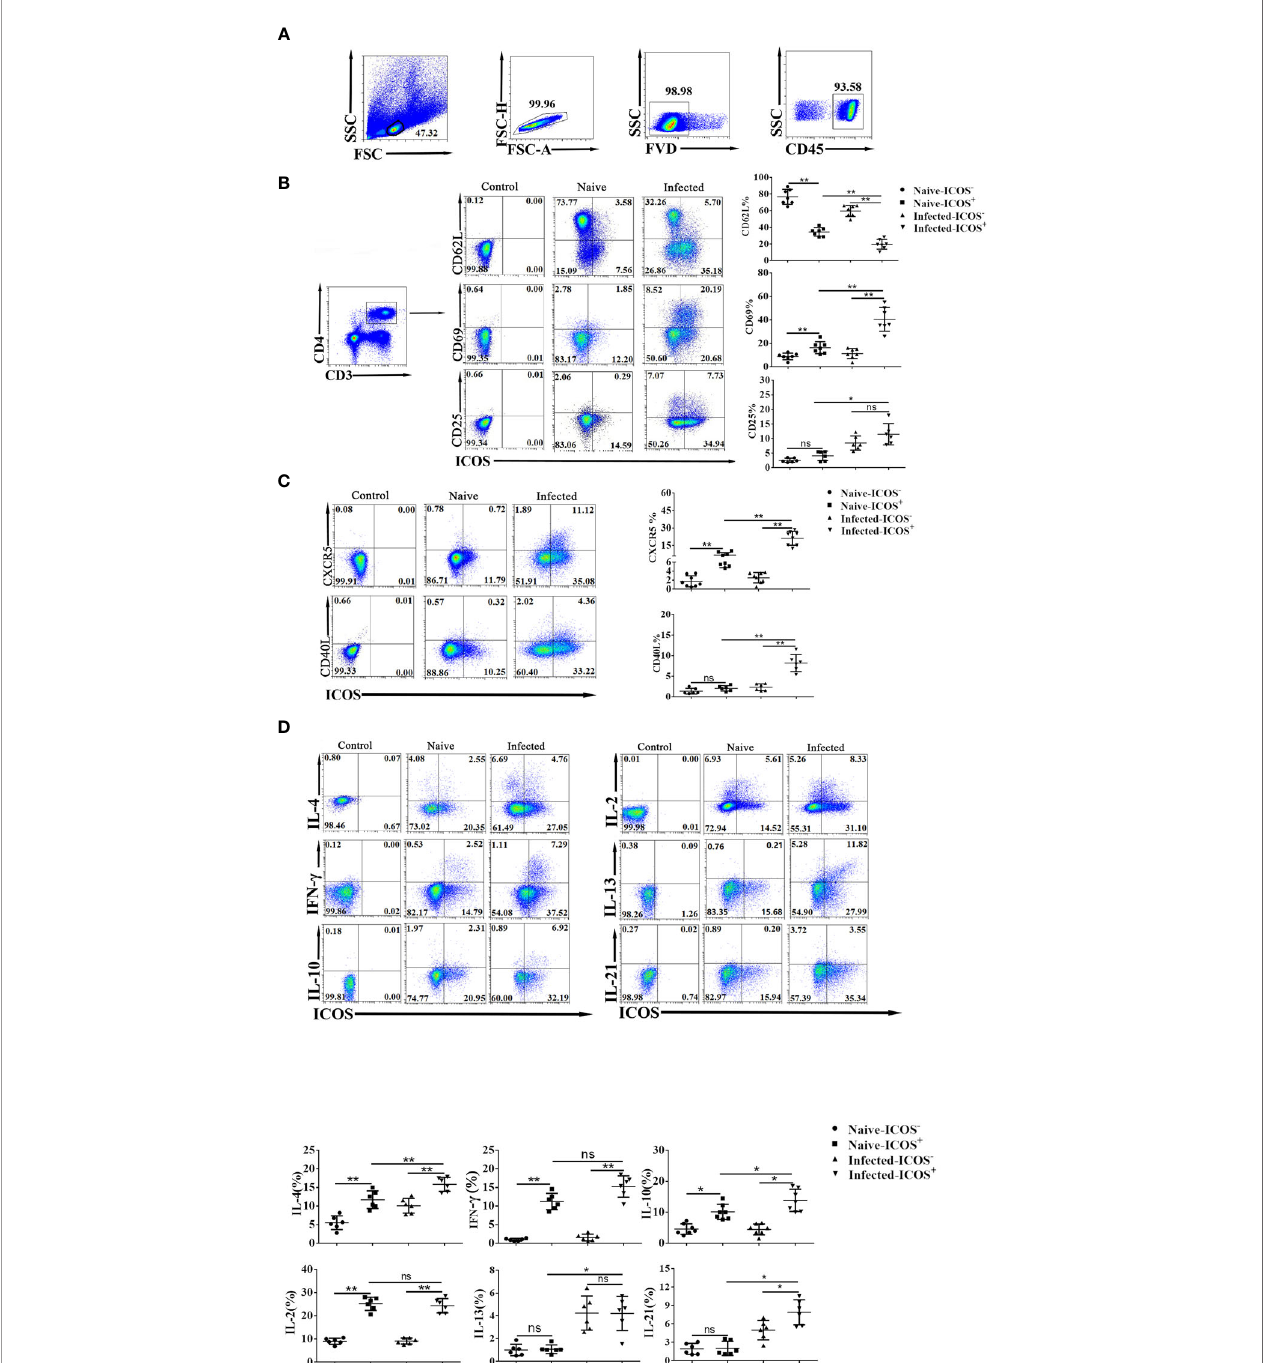
FIGURE 2 | The higher percentage of activation-associated molecules and cytokines expressed on splenic ICOS + Th cells. Five to 6 weeks after S. japonicum infection, splenocytes were isolated, stained by different fl uorescence-labeled antibodies, and detected by FACS. (A) All fl ow cytometry results were analyzed based on removing adhesions, elimination of dead cells, and gating on CD45 + CD3 + CD4 + populations. (B) Differences in activation markers of ICOS − Th cells and ICOS + Th cells in infected mice and naive mice. (C) The expression differences of functionally related surface markers in the two groups. (D) Splenocytes were stimulated by PMA and ionomycin, and intracellular cytokine staining was done. The CD4 + Th cells were gated fi rstly, and the expression of IFN- g , IL-2, IL-4, IL-5, IL-10, IL-13, and IL-21 on ICOS + cells was shown. Moreover, the cytokines expressed in the ICOS − and ICOS + cells were compared between naive and infected mice. The average of three independent experiments with fi ve to six mice per group was shown and repeated three times with similar results. The error bars are SD, * P < 0.05, ** P < 0.01 and ns , not signi fi cant ( P > 0.05) compared with naive